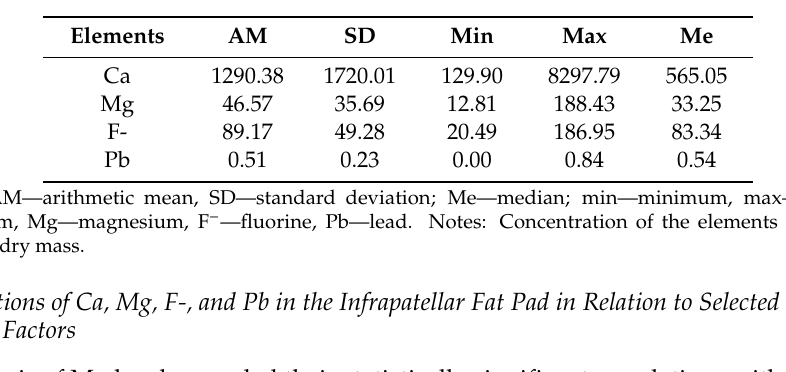
Table 1. Characteristics of the entire